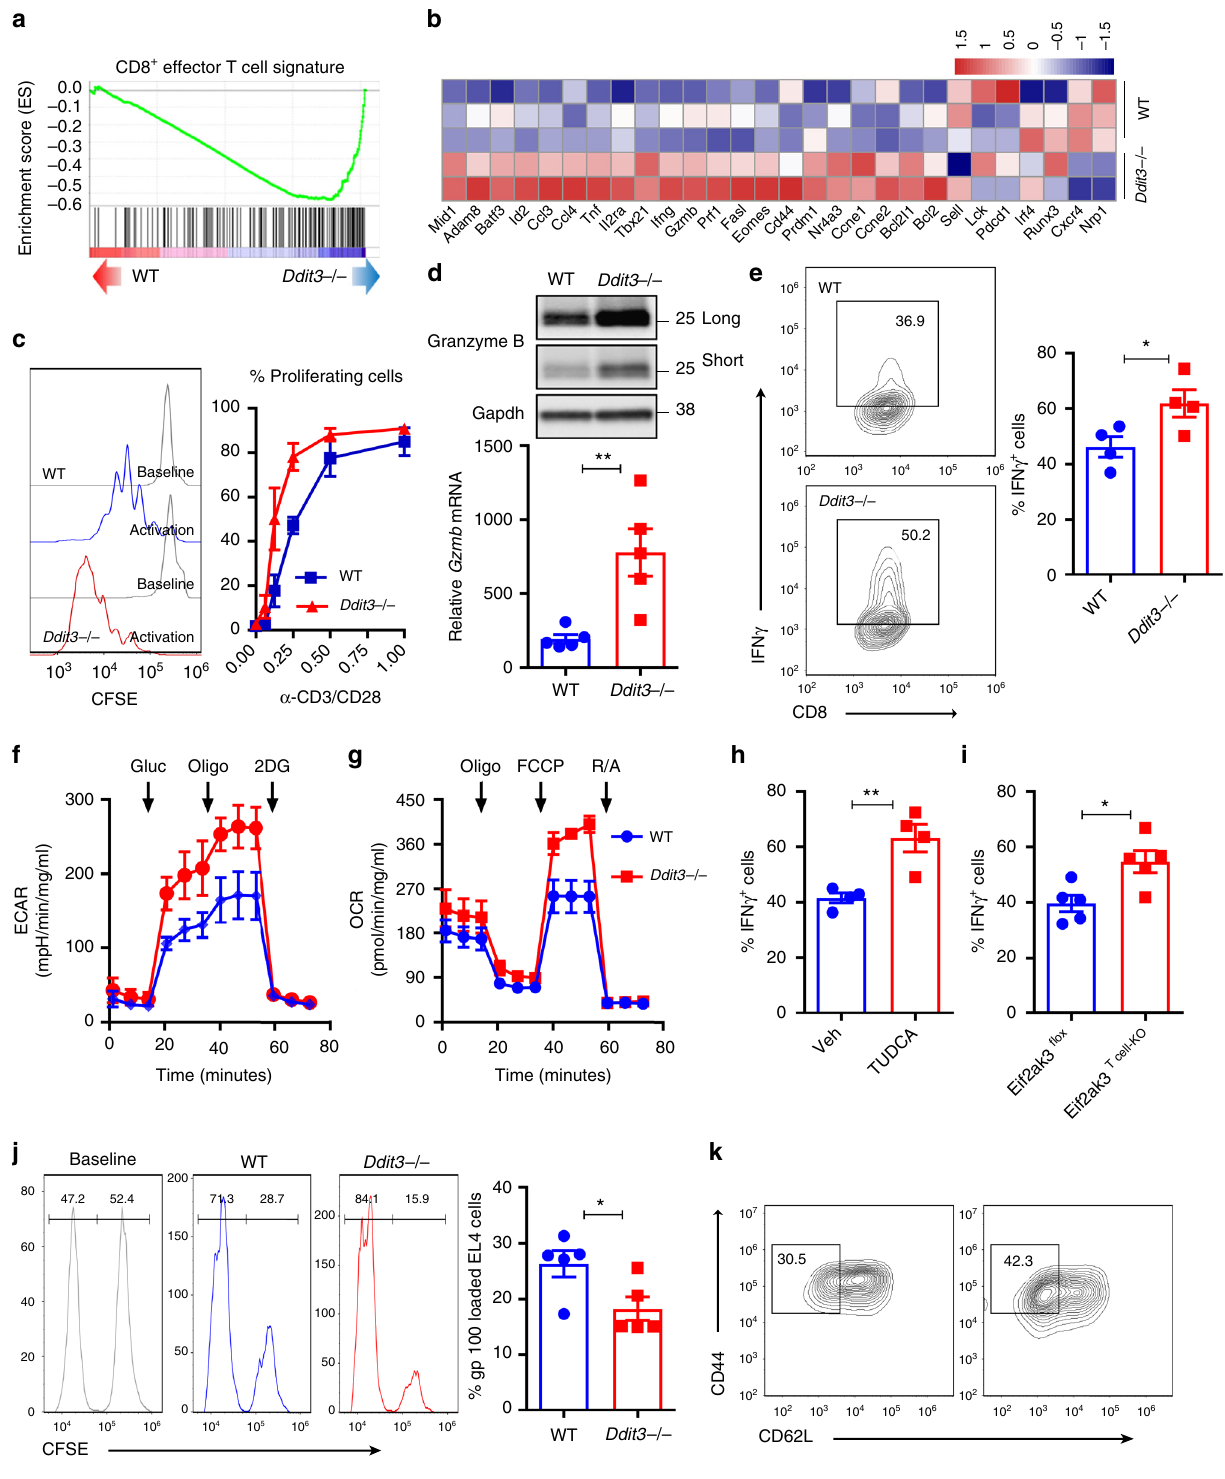
CD8 + T cell tolerance, we used an adoptive cellular therapy model against the melanoma tumor antigen gp100, in which pre- activated anti-gp100 25 – 33 transgenic CD90.1 + Pmel T cells were transferred into CD90.2 + congenic mice bearing established B16 melanoma tumors (Fig. 6a). Adoptive transfer of Ddit3 null CD8 + T cells induced a higher antitumor effect, compared to that triggered by Pmel controls (Fig. 6b), which correlated with a higher frequency of the transferred Pmel T cells expressing IFN